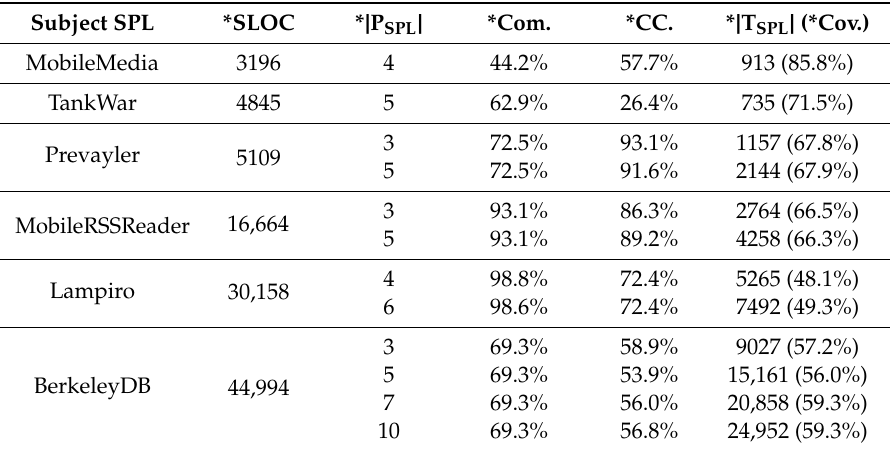
Table 3. Subject product lines used in the